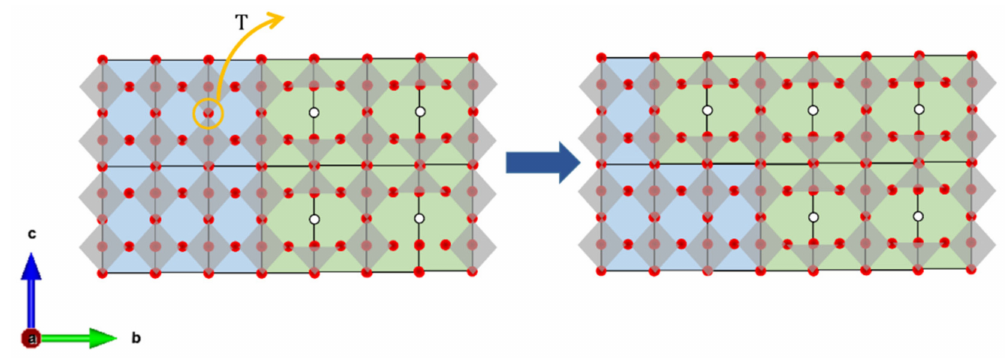
Figure 6. The scheme of the phase transition from tetragonal (blue unit cells) to orthorhombic (green unit cells)